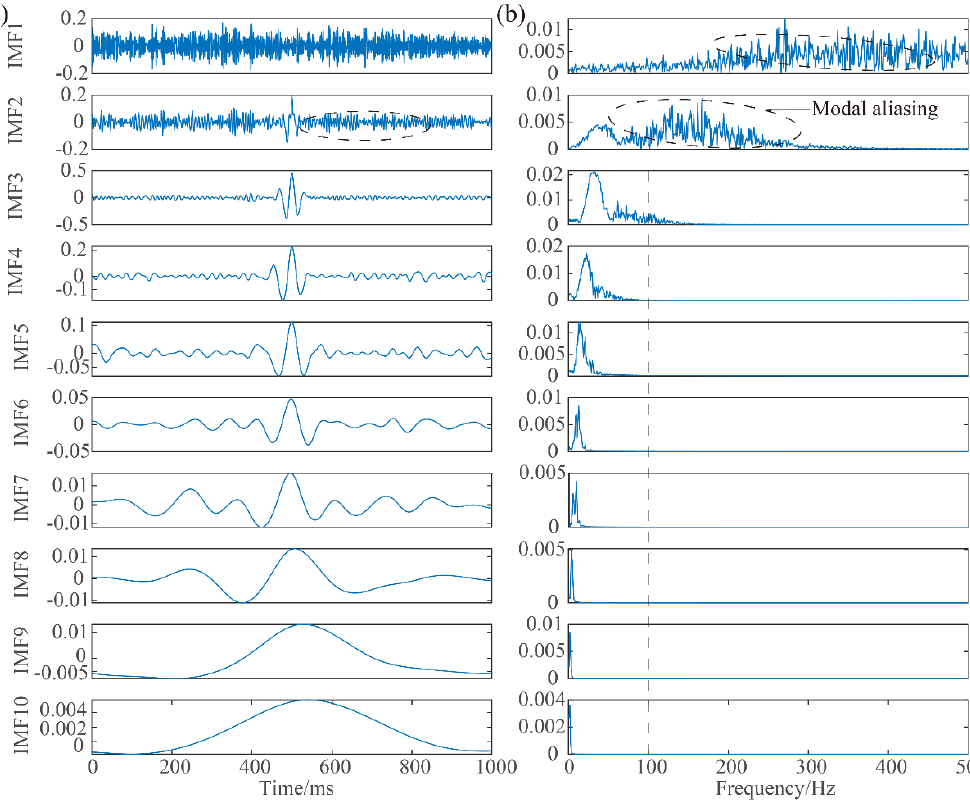
Figure 4. Waveforms and spectrograms of ten components obtained by ensemble empirical mode decomposition (EEMD). ( a ) Waveforms of components; ( b ) spectrograms of components.